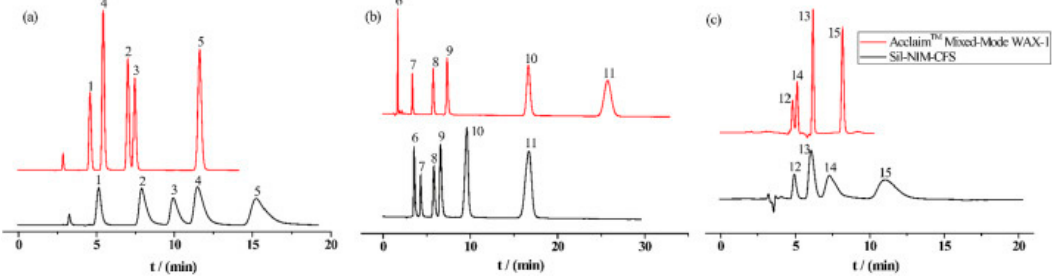
Figure 8. Separation of a mixture of nucleosides and nucleic bases, sulfonamides and inorganic anions on Sil-NIM-CFS and Acclaim™ Mixed-Mode WAX-1 columns. (1). uracil; (2). uridine; (3). cytosine; (4). adenine; (5). cytidine; (6). sulfanilamide; (7). sulfamethoxypyridazine; (8). sulfadiazine; (9). sulfathiazole; (10) sulfamethoxazole.; (11). sulfacetamide; (12). potassium bromate; (13). potassium bromide; (14). potassium iodate; (15). sodium iodide; ( a ) Mobile phase for Sil-NIM-CFS: ACN/10 mM ammonium formate (92:8, v/v ); Mobile phase for Acclaim™ Mixed-Mode WAX-1 columns: ACN/10 mM ammonium formate (80:20, v/v ); Ph = 5.6, flow rate: 0.6 mL/min, detection wavelength: 254 nm. ( b ) Mobile phase for Sil-NIM-CFS: ACN/H 2 O (50:50, v/v ), flow rate: 0.8 mL/min; Mobile phase for Acclaim™ Mixed-Mode WAX-1 columns: ACN/H 2 O (60:40, v/v ), flow rate: 1.0 mL/min; detection wavelength: 254 nm. ( c ) Mobile phase for Sil-NIM-CFS: ACN/5 mM Na 2 SO 4 (5:95, v/v ), pH = 4.28; Mobile phase for Acclaim™ Mixed-Mode WAX-1 columns: ACN/50 mM Na 3 PO 4 (50:50, v/v ), Ph = 6.0; flow rate: 0.6 mL/min; detection wavelength: 210 nm; Injection volume: 40 µL, column temperature: 25 °C. Figure adopted with permission from [165].